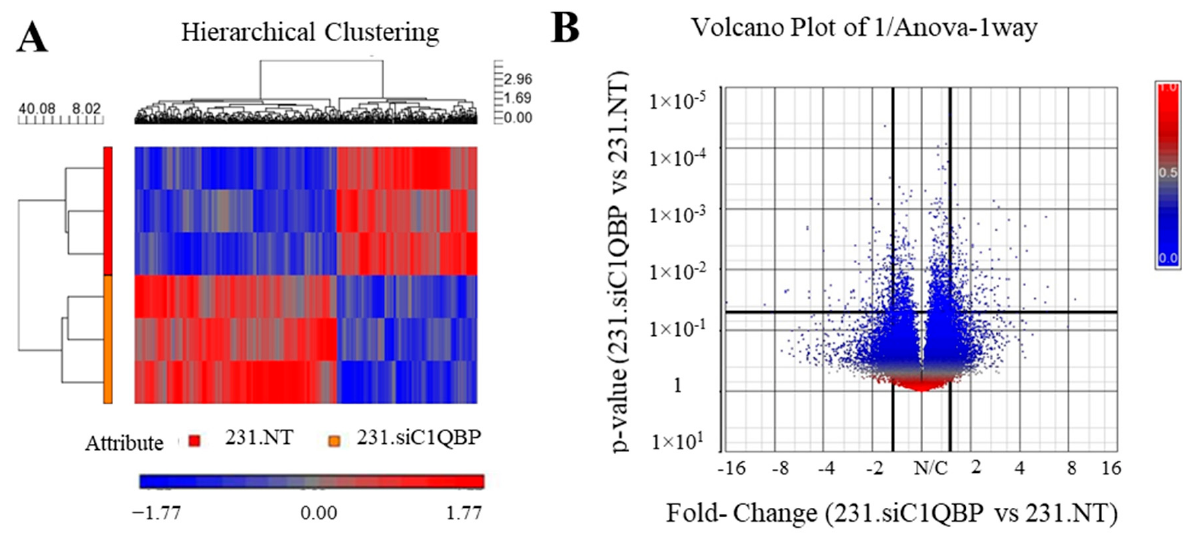
Figure 4. ( A ) Hierarchical clustering concurrent with ( B ) volcano plot of the genes obtained from the Affymetrix gene chip. Thick vertical lines and horizontal lines in the volcano plot represent the chosen cut off of fold change of 1.5 and p < 0.05.